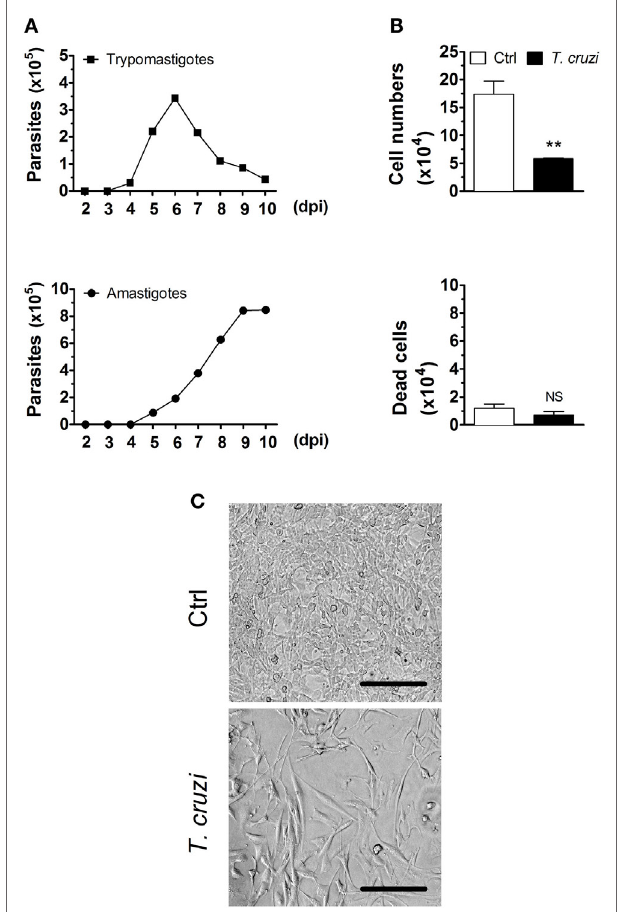
FigUre 1 | Trypanosoma cruzi infection decreases the number of fibroblasts in culture. NIH-3T3 fibroblasts were infected with culture-derived trypomastigotes of T. cruzi (MOI 5:1). (a) Assessment of extracellular parasitic load (trypomastigote and amastigote forms) in culture supernatants over 10 days of infection. (B) Quantification of the number of T. cruzi -infected or non-infected fibroblasts after 3 days post-infection in the optical microscope. Dead cells were evaluated by Trypan blue exclusion assay. (c) Photographs are representative of six randomly chosen fields and denote a confluent cell culture in the absence but not in the presence of T. cruzi infection (20 × magnification). Scale bars are equal to 50 µm. Data are presented as the mean ± SE of three biological replicates. Data were log-transformed and analyzed by unpaired, two-tailed Student’s t -test. ** p < 0.01; NS, not significant, p > 0.05. Data are representative of at least three independent experiments with similar results. Abbreviations: MOI, multiplicity of infection; dpi, days post-infection; Ctrl,